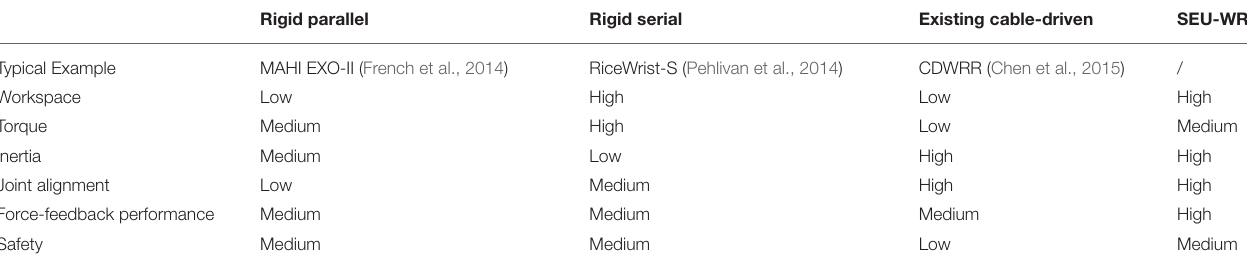
TABLE 1 | The performance comparison of several typical exoskeleton. Rigid